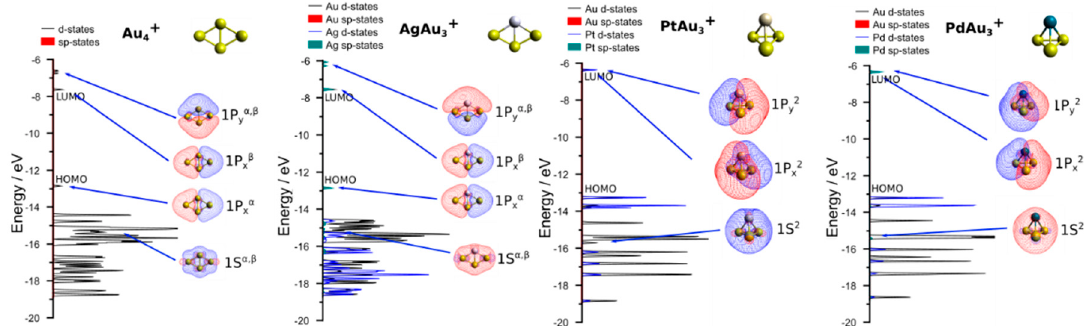
Figure 5. Total density of states of the clusters composed of N = 4 atoms. Projections into atomic states are presented in black for Au(d), in red for Au(s p ), in blue for M (d), and in green for M (s p ). The molecular orbitals of delocalized character extending over the entire cluster volume are plotted and labeled based on their nodal character (1S and 1P x,y ). The HOMO-LUMO gap is labeled. In the case that the cluster is open-shell, both α and β orbitals are plotted.